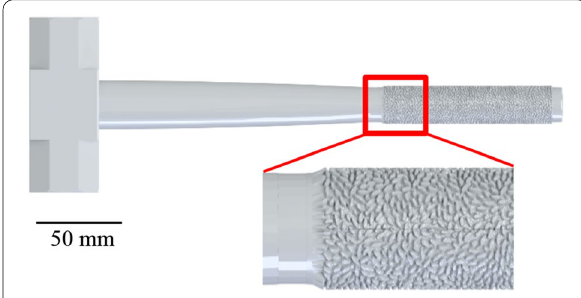
Figure 14 Sledgehammer with textured grip; angle preserving mapping